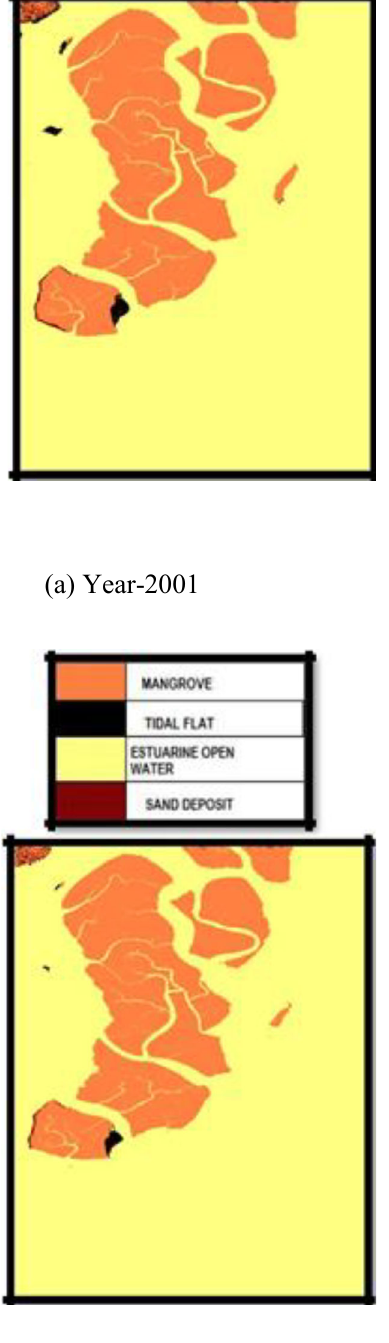
(b) Year-2016 Figure3: Classified Images based on National Wetland Inventory (NWI) Classification